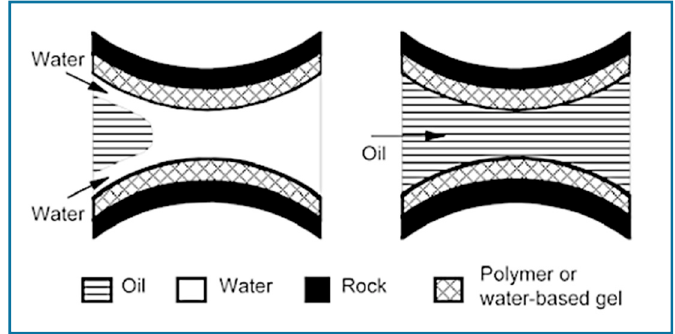
Figure 7. Wall-e ff ect model: water-based polymer with “water-wet” rock (adapted from